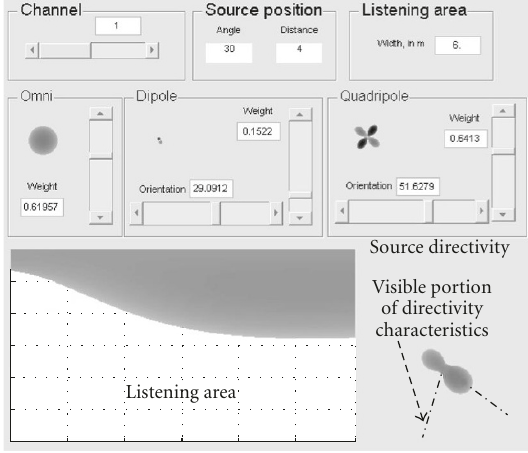
Figure 21: M3S directivity